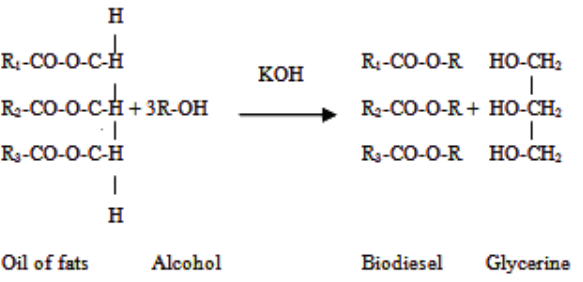
Fig. 1. A schematic depiction of the transesterification of triglycerides (vegetable oil) with methanol to generate fatty acid methyl esters